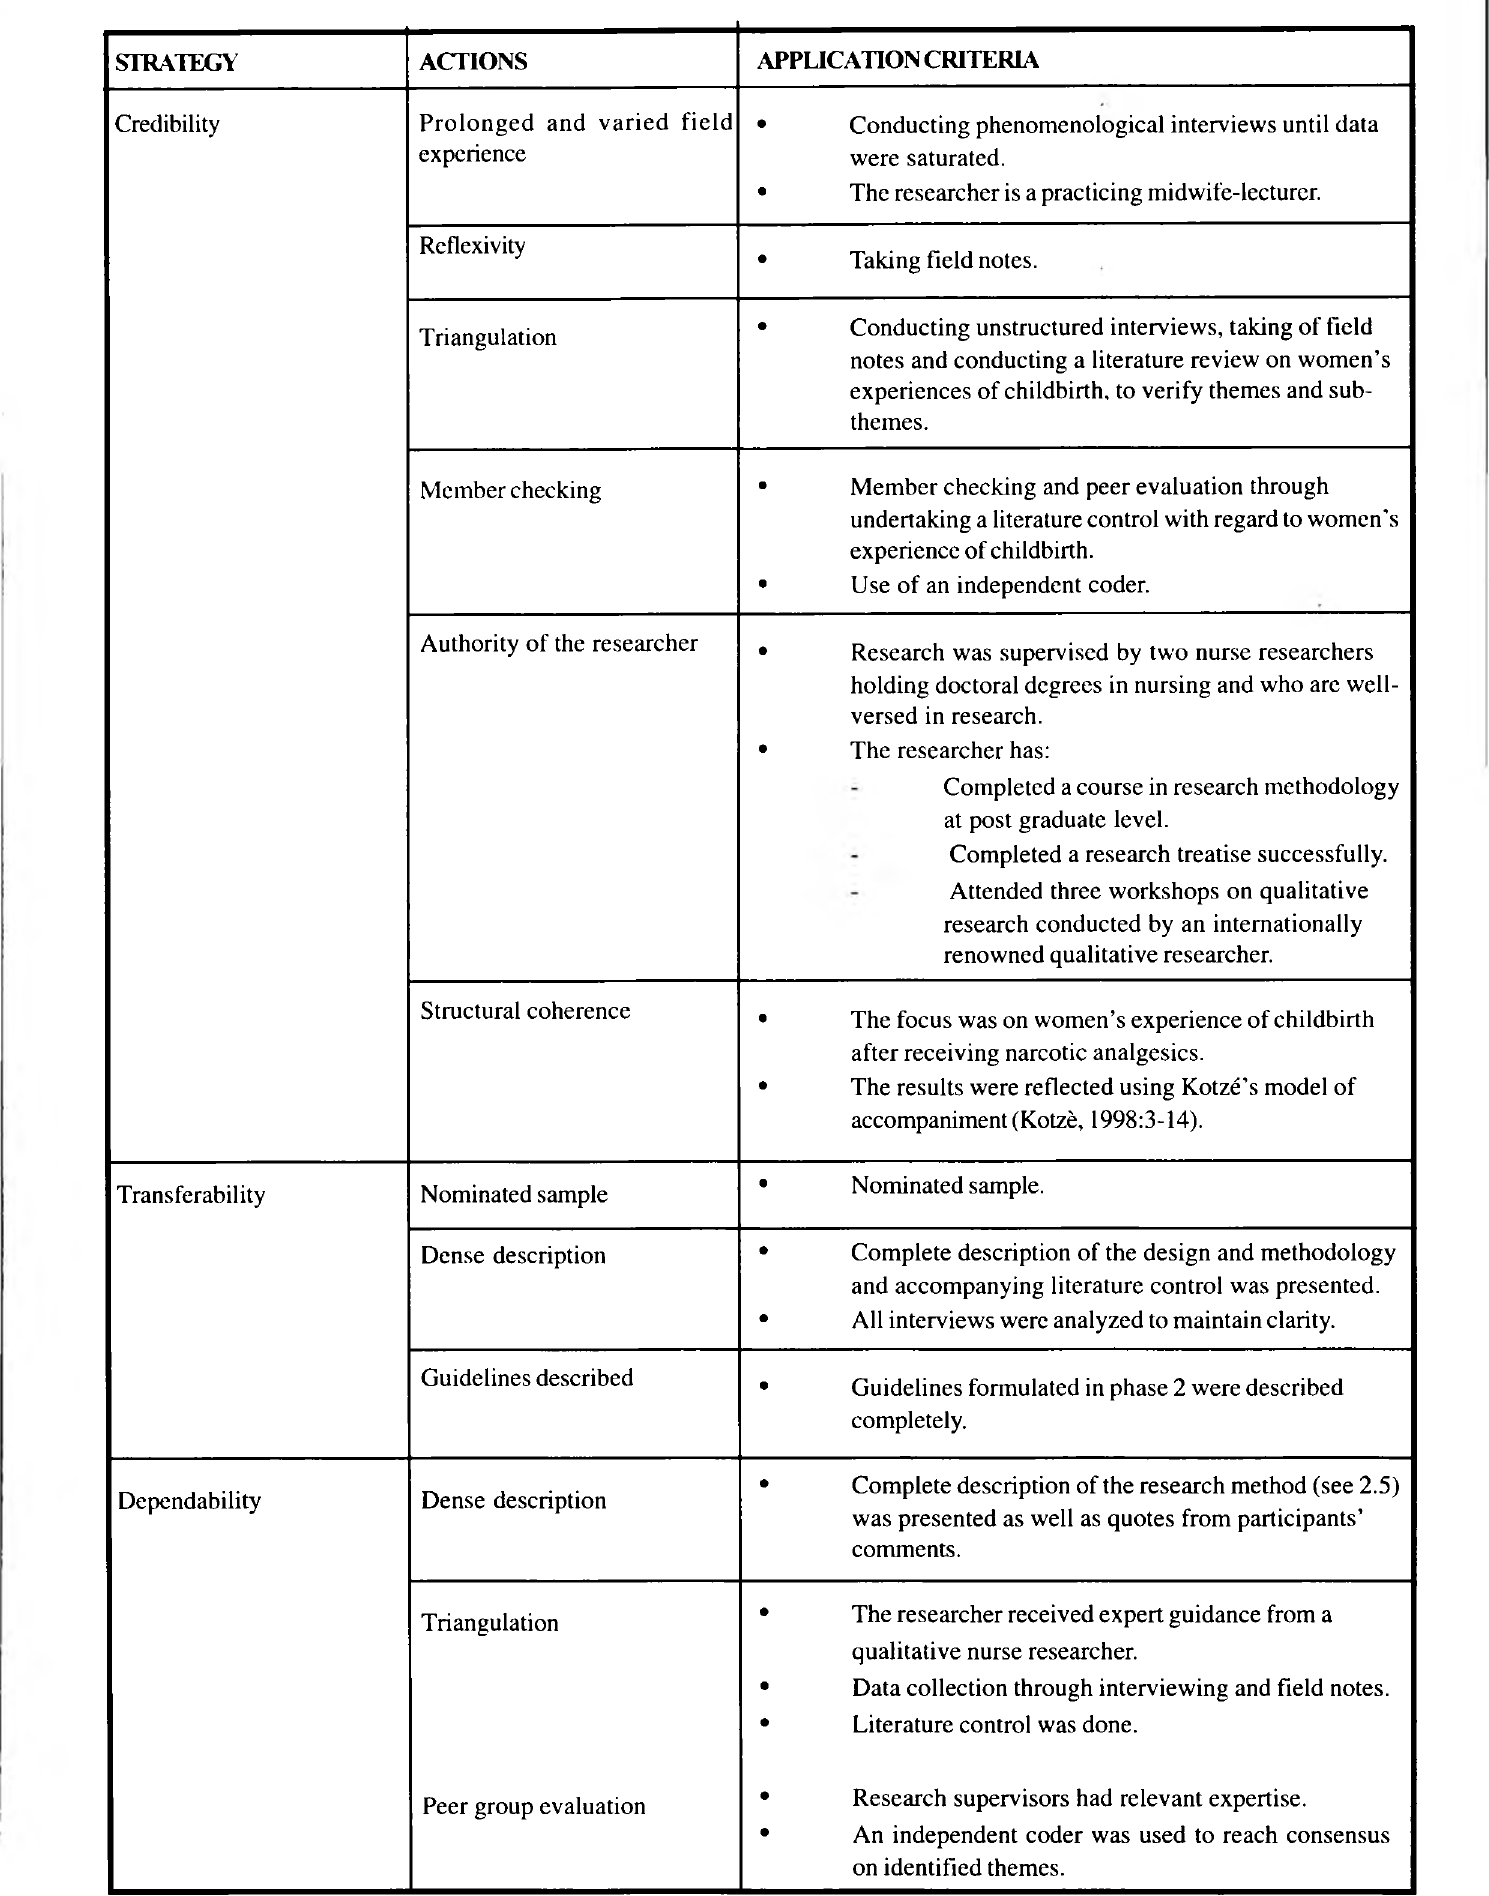
Tablel: Strategies to ensure trustworthiness